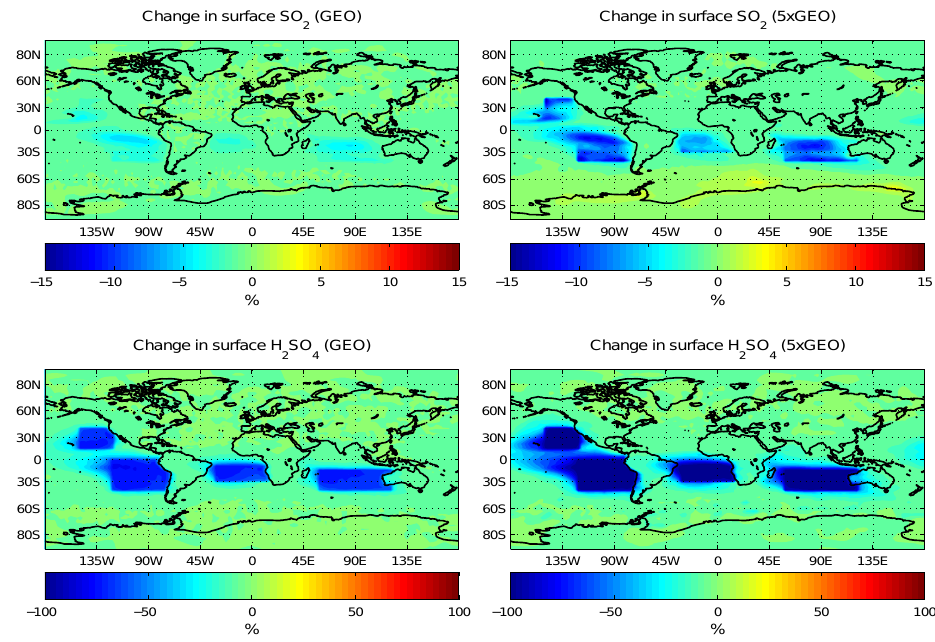
Fig. 7. Effect of cloud seeding on the annual mean surface level concentrations of SO 2 (top panels) and H 2 SO 4 (bottom panels).